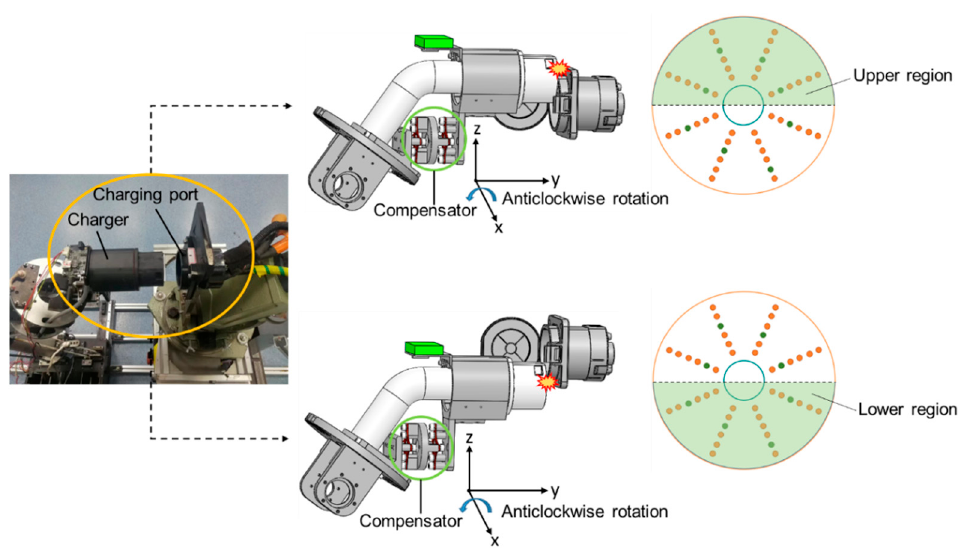
Figure 3. The collision process between the charger and the charging